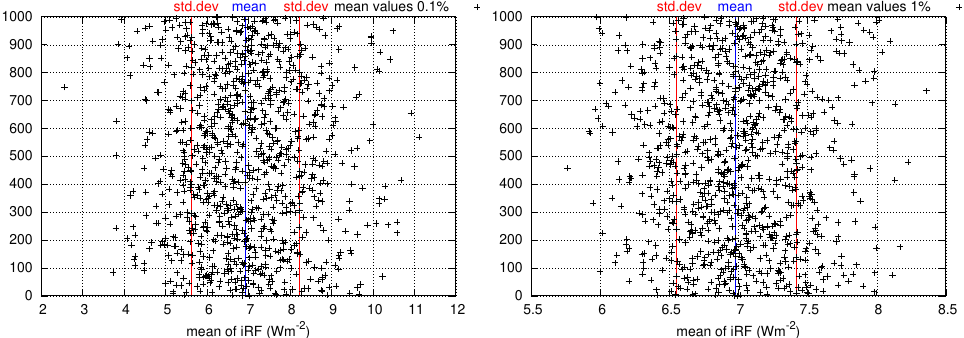
Figure 6. Sample means (plus signs) from the overall dataset of iRF values, determined 1000 times with 0.1% of the data ( left ) and another 1000 times with 1% of the data ( right ). The blue lines mark the respective mean of the 1000 sample means, the red lines the corresponding plus/minus one standard deviation ranges. Note the different ranges on the